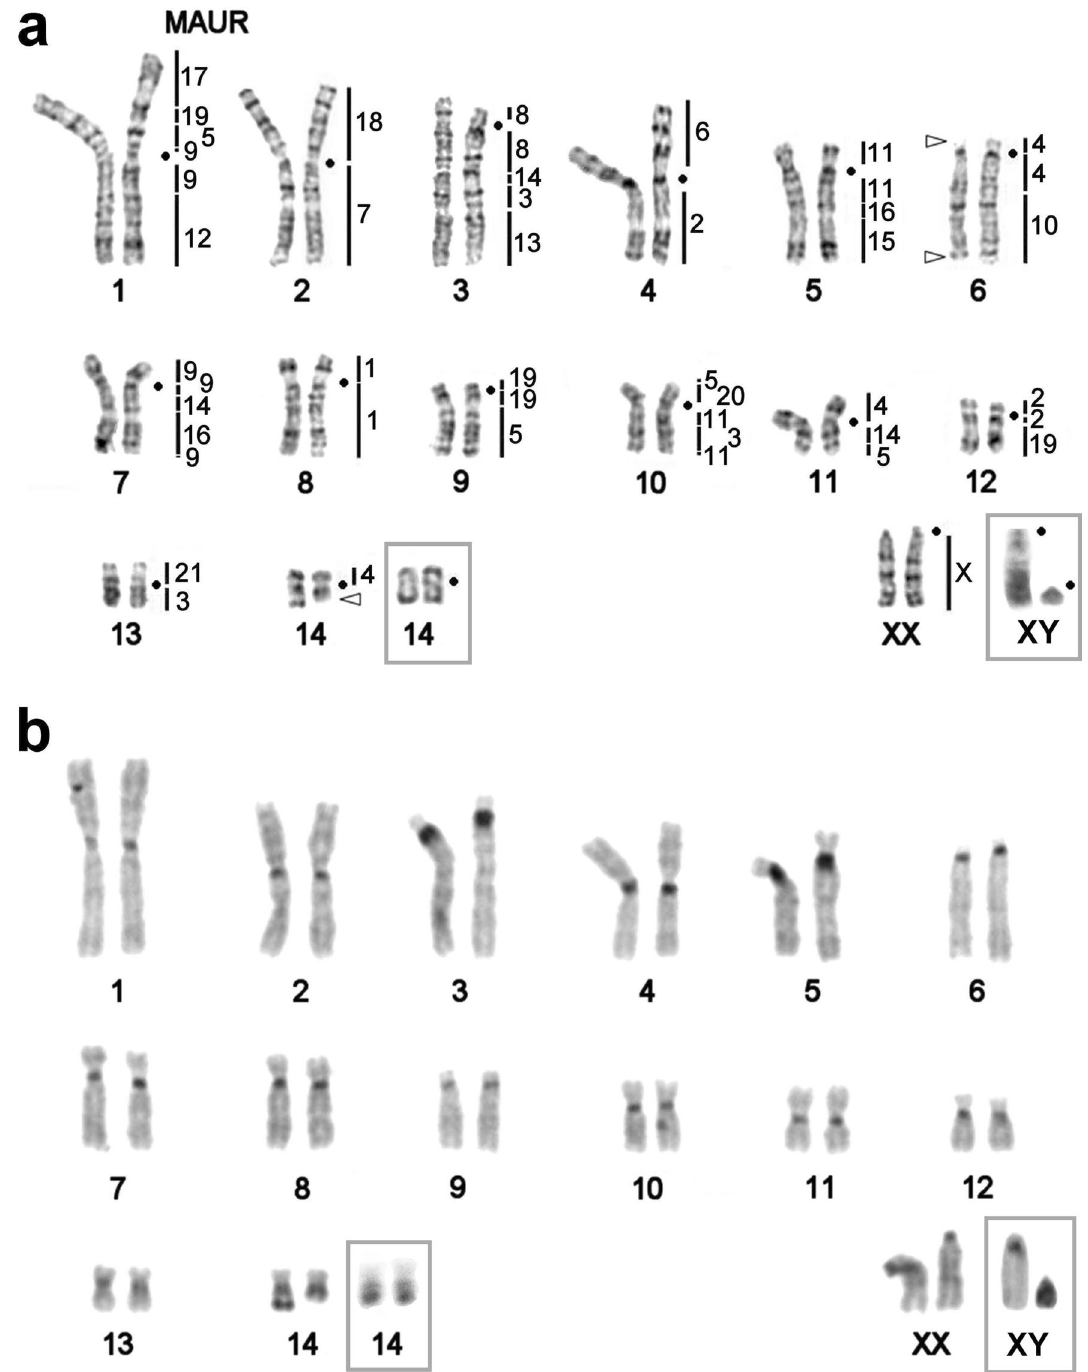
Figure 1. The female karyotype of U. kamensis , 2n = 30, NF a = 50. ( a ) Localization of M. auratus probes (black lines) and the rDNA probe (triangles) on G-banded chromosomes. Centromere positions are marked by black points. ( b ) C-banding. Male sex chromosomes and pair No. 14 are presented in the grey